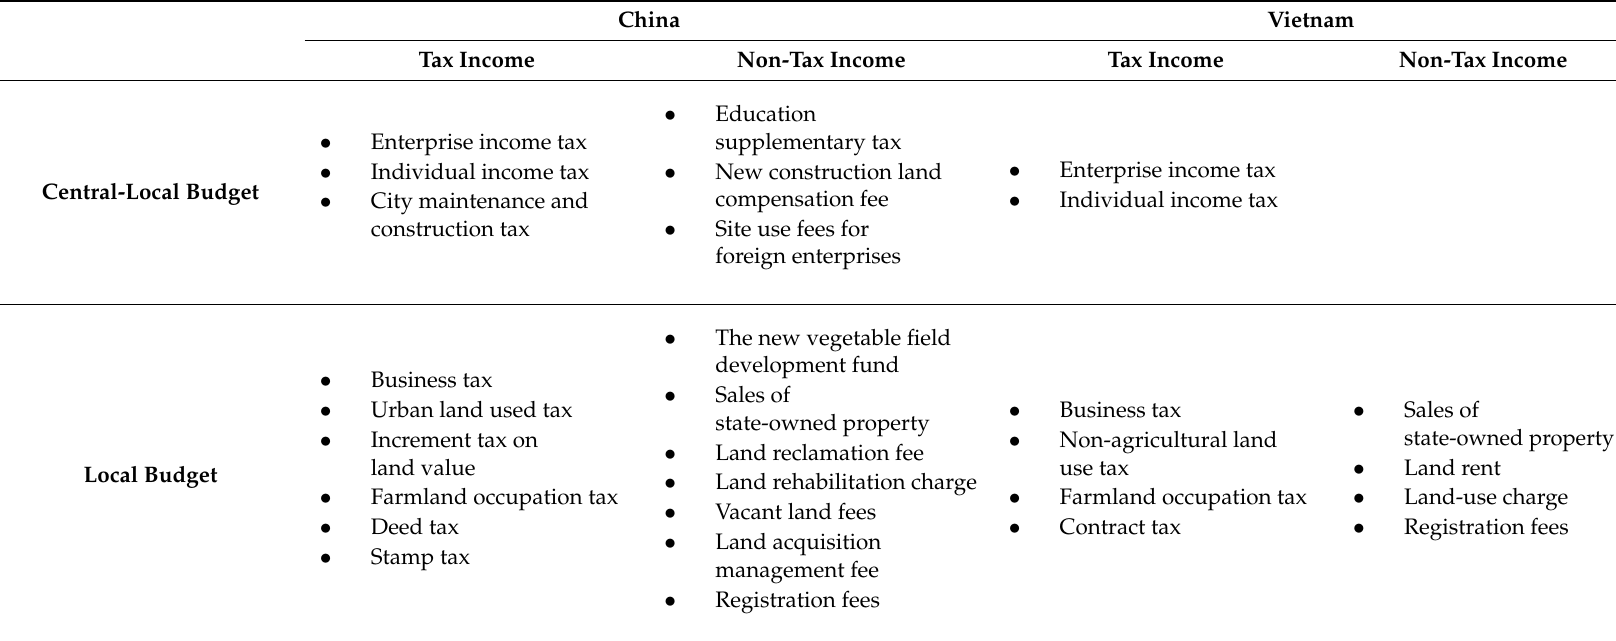
Table 1. Land revenue sharing between central-local governments in China and Vietnam. (Source: the authors).